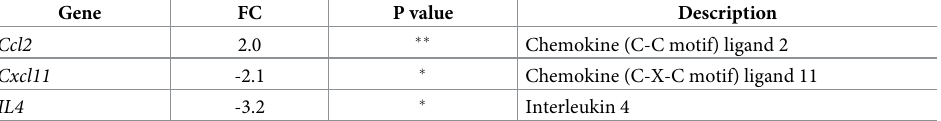
Table 3. Proinflammatory genes altered in brains of 22L-infected Tlr2 -/- mice relative to 22L-infected C57BL/6 mice at the terminal timepoint. Gene FC P value Description Ccl2 2.0 �� Chemokine (C-C motif) ligand 2 Cxcl11 -2.1 IL4 -3.2 � Interleukin 4 Fold Change (FC) in infected Tlr2 -/- mice (n = 4) relative to infected C57BL/10 mice (n = 4). P values are calculated using the Student t-test � P value � 0.05 �� See Supplemental data for full